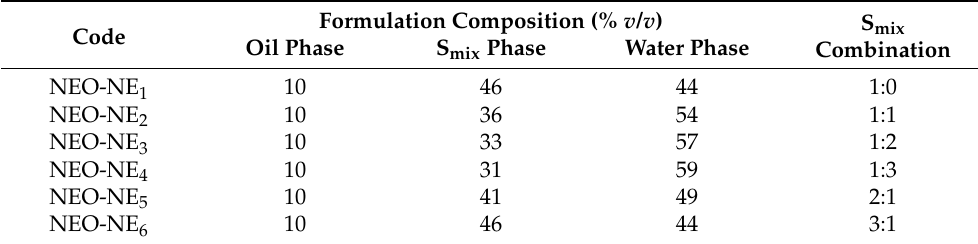
Table 2. Composition of selected NEO-NEs that passed thermodynamic stability tests.